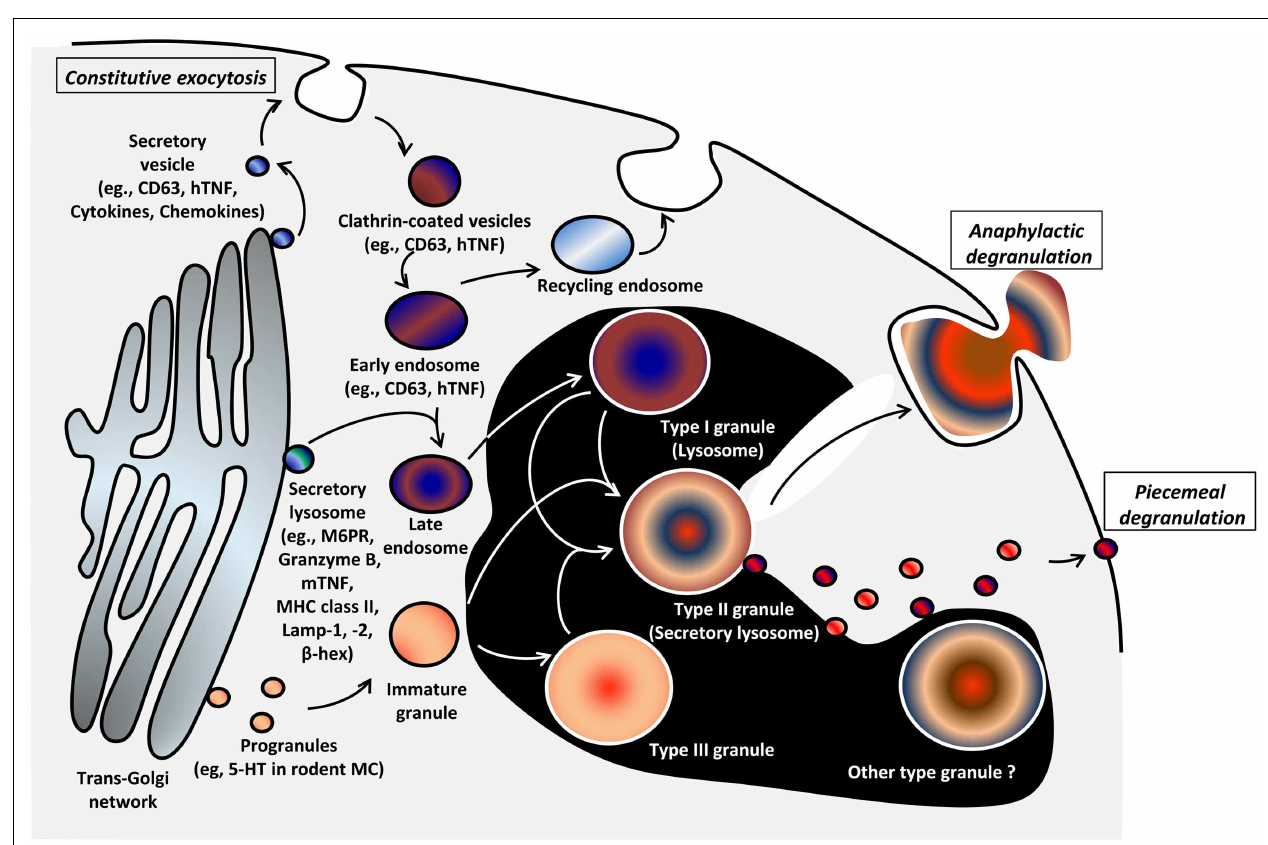
postulated that post-endosomal, type II secretory lysosomes arise through the fusion ofType I and III granules.The relationship of this model to observations of heterogeneity of secretory lysosomes with regard to histamine or 5-HT content andVAMP-8 expression is unclear and there likely exists more granule heterogeneity/plasticity than three types (44). The mechanism of genesis of granule types is poorly understood (black